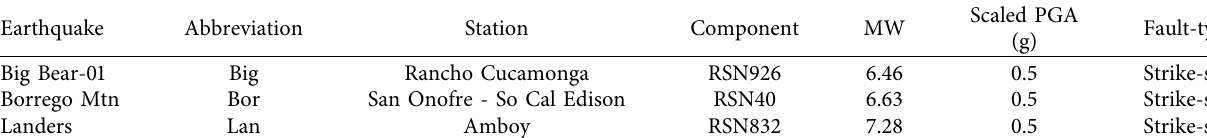
Figure 5: Scaled earthquakes acceleration response spectrum. Table 3: Scaled earthquakes